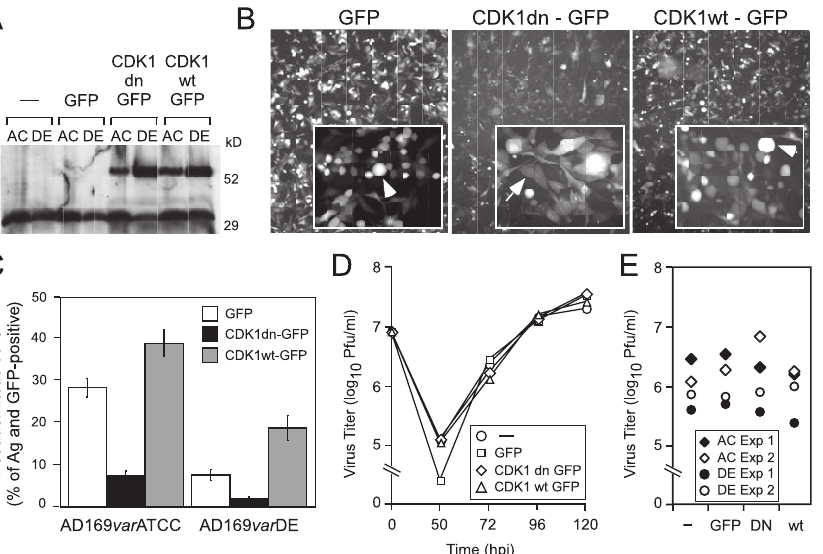
Figure 2. Impact of Cdk1 on Pseudomitosis and Replication (A) Immunoblot analysis of Cdk1 expression in protein extracts from nontransduced ( (cid:2) ) and GFP-, Cdk1wt-GFP (cid:2) , or Cdk1dn-GFP (cid:2) transduced HFs infected with AD169 var ATCC (AC) or AD169 var DE (DE) for 72 h. The blot was incubated with an anti-Cdk1 monoclonal antibody (mAb) as described in Materials and Methods. Expected molecular weights: 34 kDa for Cdk1 and 61 kDa for Cdk1wt or dn-GFP. Black arrowhead, endogenous Cdk1; gray arrowhead, recombinant Cdk1. (B) GFP fluorescence images of HFs transduced with retroviruses expressing GFP, Cdk1wt-GFP, or Cdk1dn-GFP and infected with AD169 var ATCC for 72 h (original magnification 3 50). Higher magnification images ( 3 200) are displayed in the insets. Arrowheads indicate representative pseudomitotic cells; arrows indicate interphase cells. (C) Percentage of IE1/IE2 þ and GFP þ pseudomitotic cells in GFP-, Cdk1wt-GFP (cid:2) , or Cdk1dn-GFP (cid:2) transduced HFs infected with AD169 var ATCC or AD169 var DE for 72 h. Mean percentages and standard deviation from four independent experiments are shown. (D) Viral yields from nontransduced ( (cid:2) ) and GFP-, Cdk1wt-GFP (cid:2) , or Cdk1dn-GFP (cid:2) transduced HFs infected with AD169 var ATCC for 50, 72, 96, and 120 h in one representative experiment. (E) Viral yields from nontransduced ( (cid:2) ) and GFP-, Cdk1wt-GFP (cid:2) , or Cdk1dn-GFP (cid:2) transduced HFs infected with AD169 var ATCC or AD169 var DE for 72 h in two independent